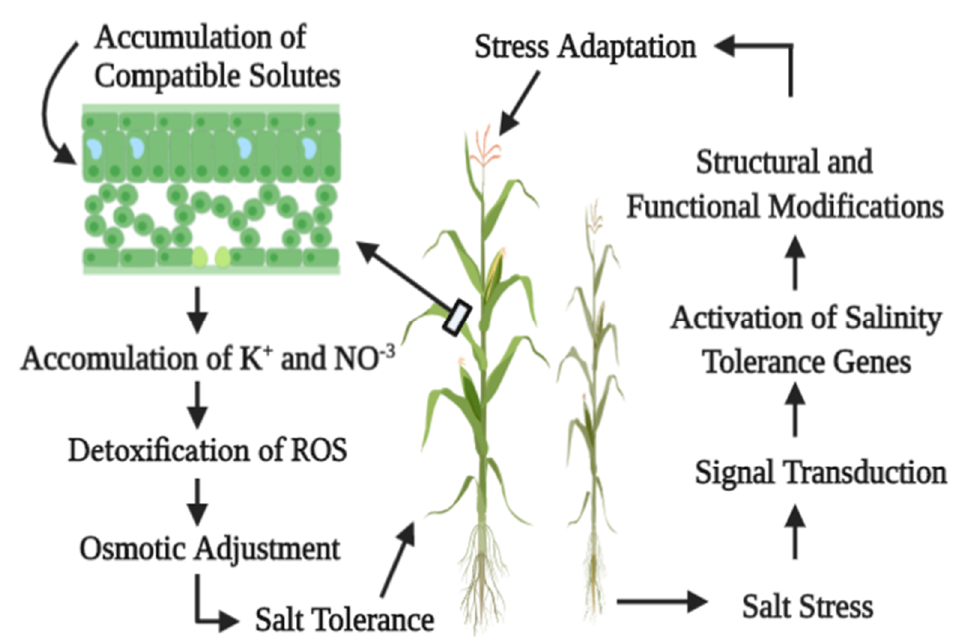
Figure 1. Salt stress signals that bind to their respective receptors and initiate the physiological and molecular mechanisms to enable a plant to survive under stressed conditions.